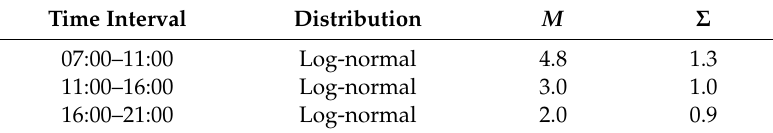
Table 2. Parameter of residual state of charge ( SoC ) pdf.